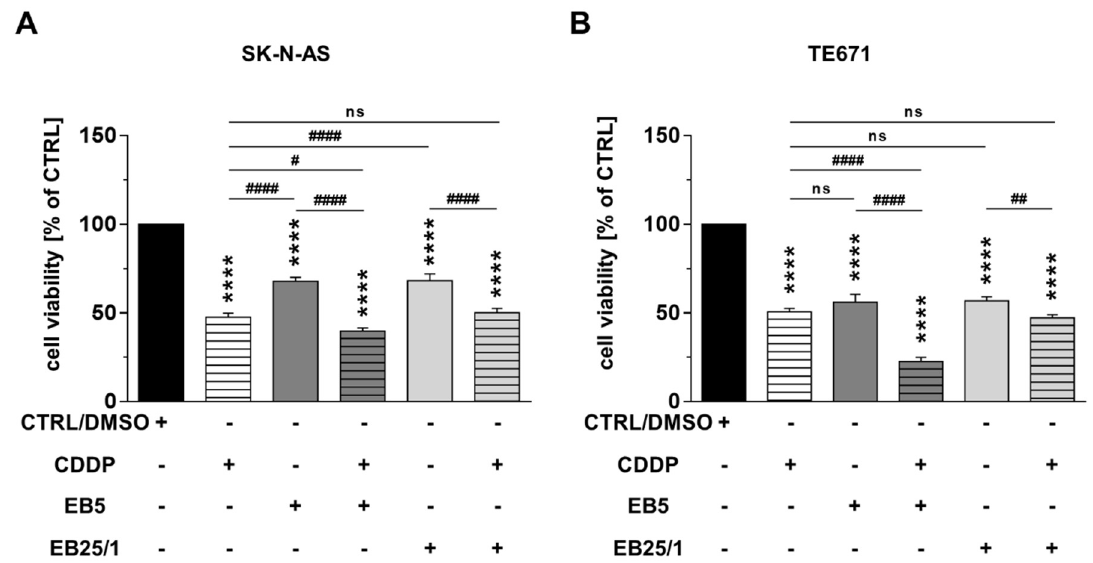
Figure 3. Combination of ASBDs with CDDP enhances cytotoxicity of both CDDP and EB5 administered singly. SK-N-AS and TE671 cell lines were treated with CDDP and ASBDs (the doses of IC 50 values), and ASBDs in combination with CDDP (the doses of IC 50 value) for 96 h and then analyzed with MTT metabolism assay for cell viability/survival. ( A ) The bar graph presents cell viability of SK-N-AS cells after treatment with CDDP, EB5, EB25/1 and combination of CDDP with EB5 or EB25/1. ( B ) The bar graph presents cell viability of TE671 cells after treatment with CDDP, EB5, EB25/1 and combination of CDDP with EB5 or EB25/1. The results were normalized to control cells (CTRL, 0.1% DMSO as a solvent control) and represent the mean ± SEM n = 32 from 4 independent experiments. Statistical significance was determined by one-way analysis of variance (ANOVA) followed by Tukey’s post hoc test for multiple comparisons. p values were considered significant when p ≤ 0.0001 (****, vs. CTRL) and p ≤ 0.05 (#), p ≤ 0.01 (##), p ≤ 0.0001 (####).